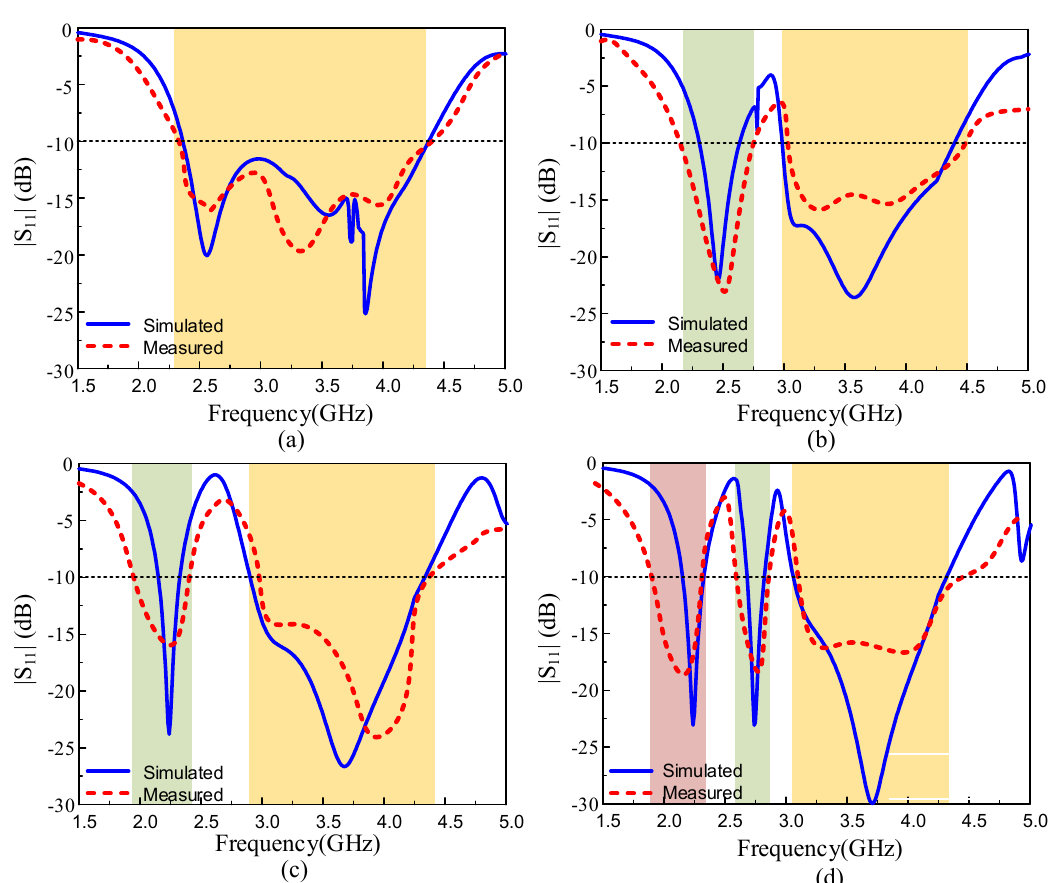
Figure 9. Simulated and measured results of S 11 : ( a ) case-11 ( b ) case-01 ( c ) case-10 ( d ) case-00.